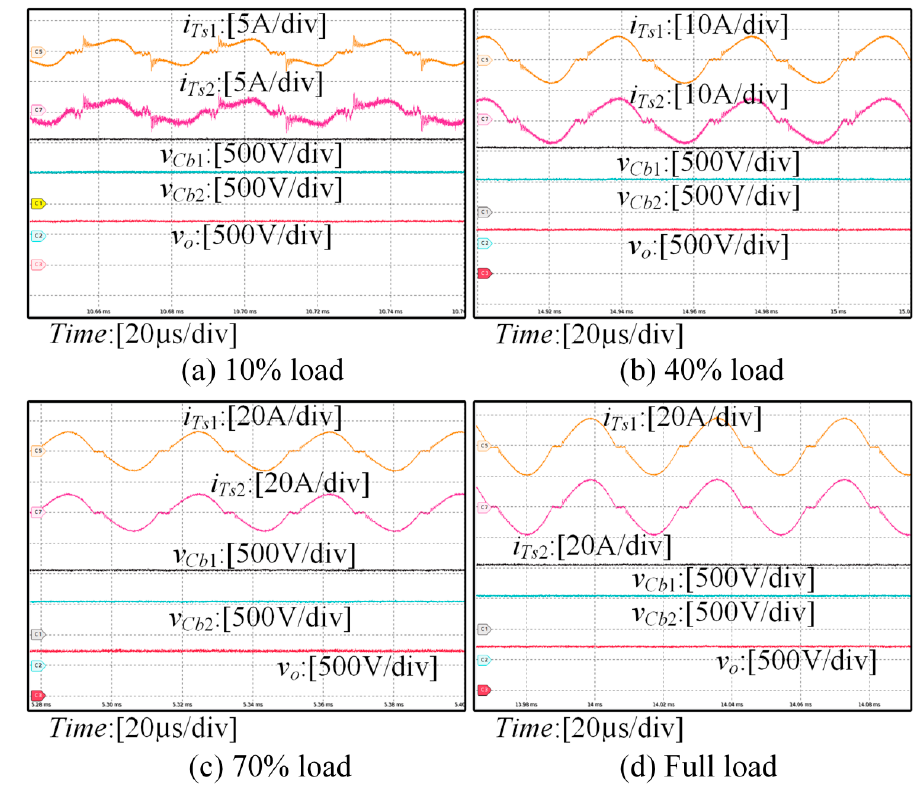
Figure 14. Experimental waveforms at different loads.